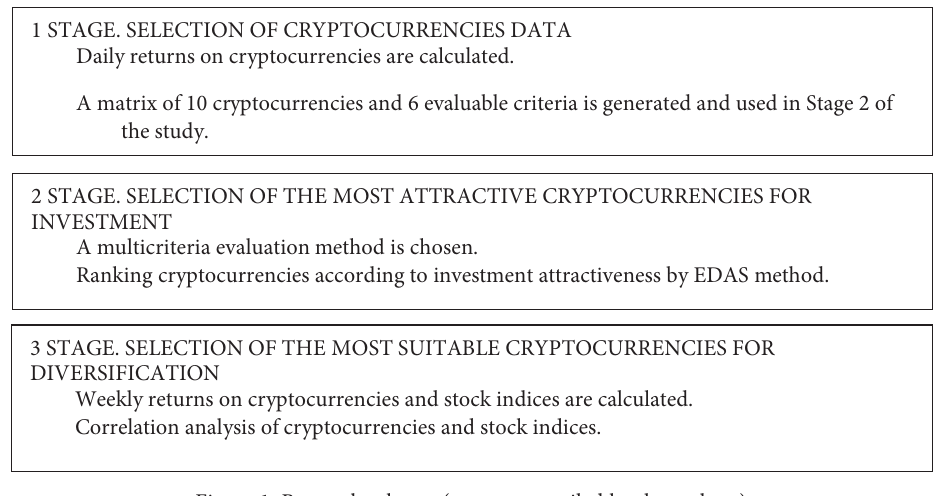
Figure 1. Research scheme (source: compiled by the